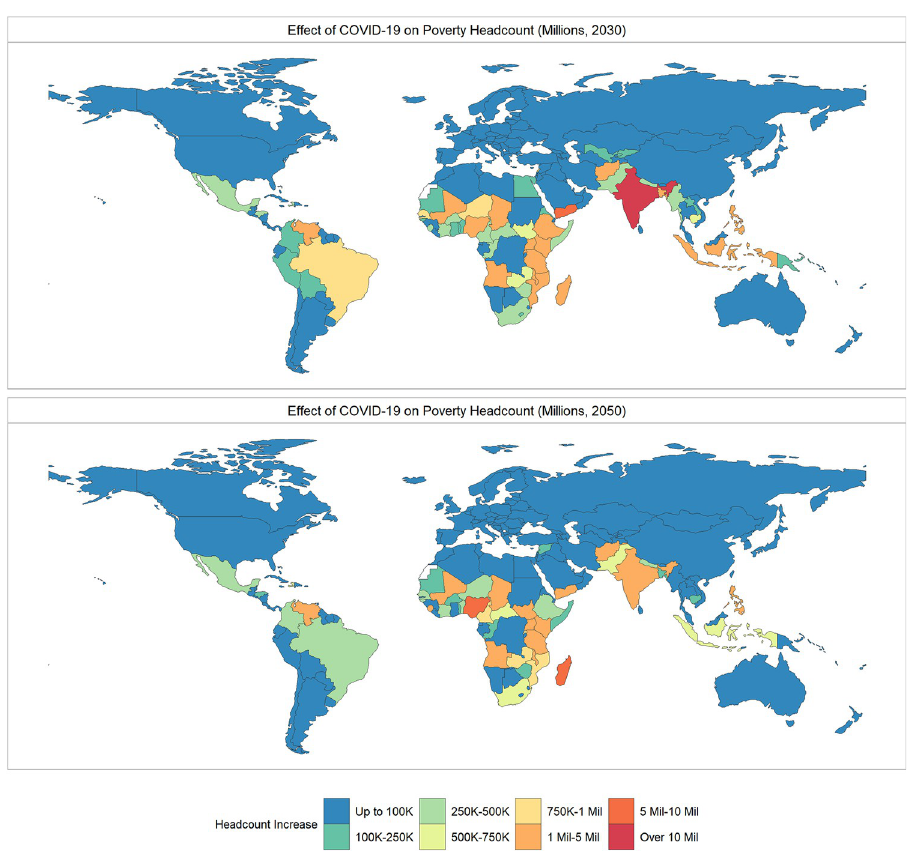
Fig 4. Absolute increate in extreme poverty by country due to COVID-19. The top panel shows the results for a comparison of the No COVID Base and the COVID-Base for 2030, the bottom panel shows the same comparison for 2050. Source: Author’s computation. Shapefiles for map sourced from the NaturalEarth project (naturalearthdata.